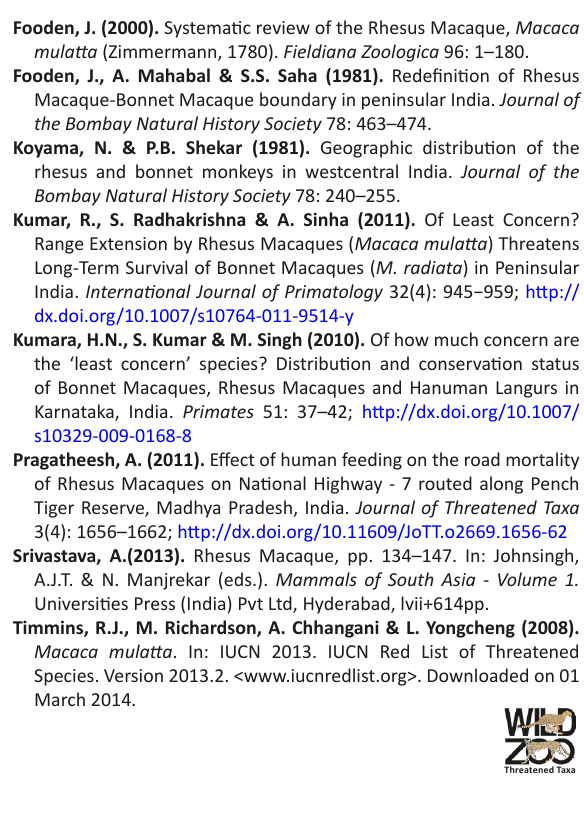
road as we approached the group